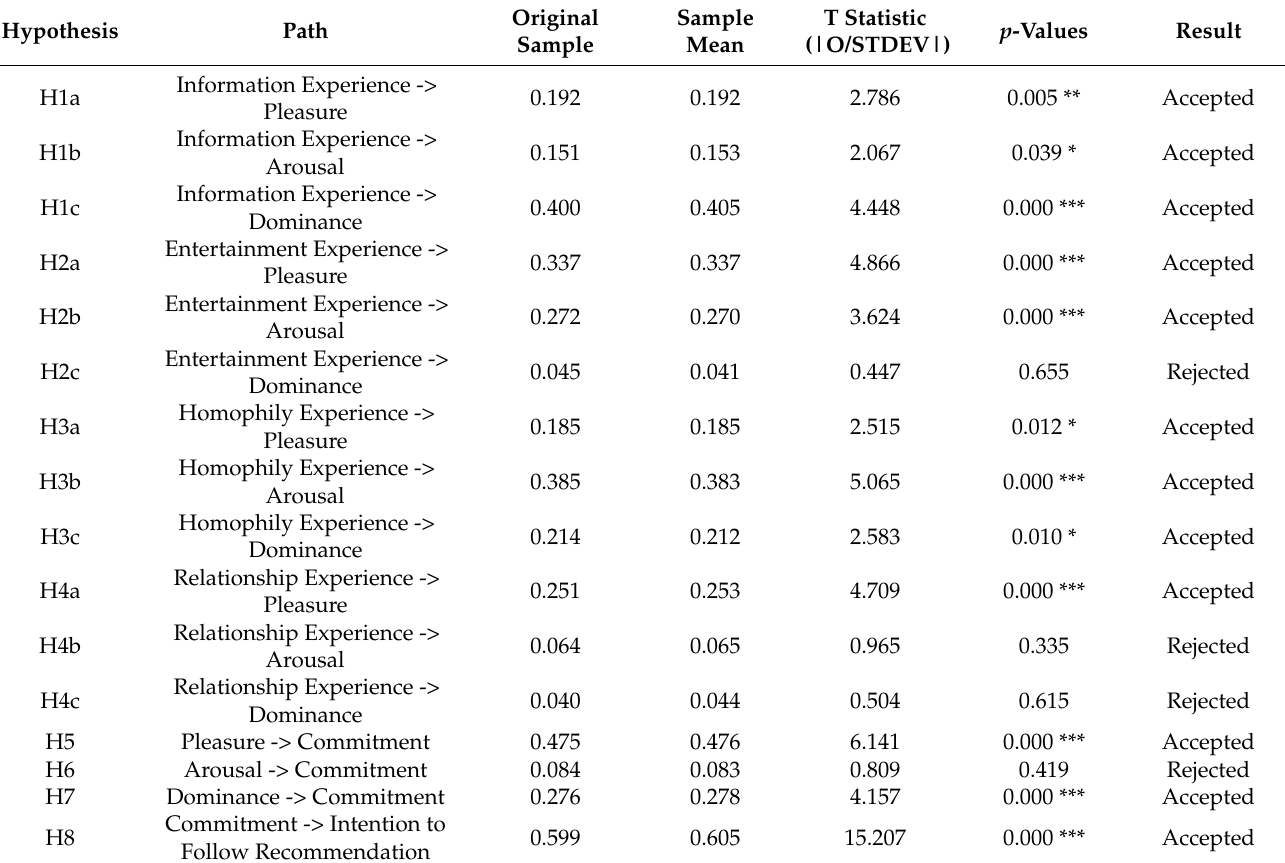
Table 6. Structural model test